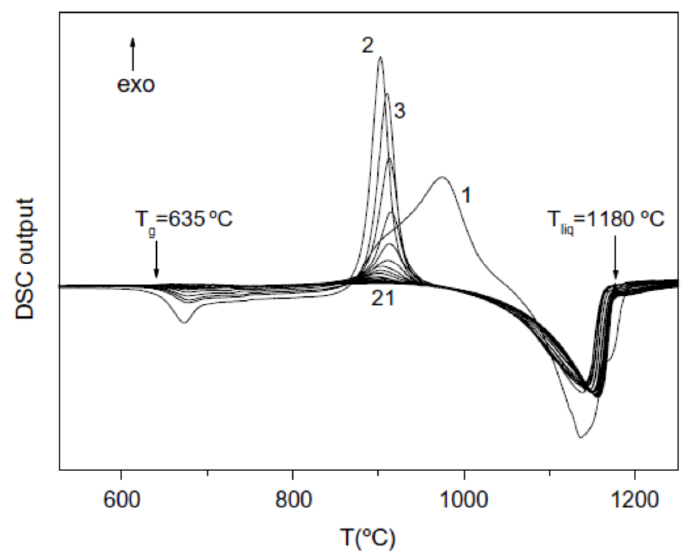
Figure 5. The repeated DSC up-scanning to 1250 °C (T liq + 70 °C) at 0.333 K/s. The numerals next to the graphs represent the order of the DSC up-scans. The measurements are performed in argon at the heating rate 20 °C/min. Reprinted with permission from ref. [44], Figure 2, Copyright 2004 Elsevier.